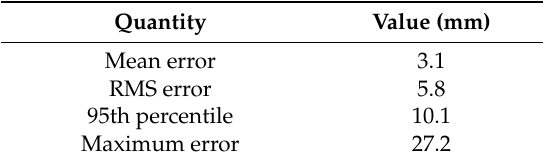
Table 3. Descriptive statistics of the error of the dynamic scan in indoor